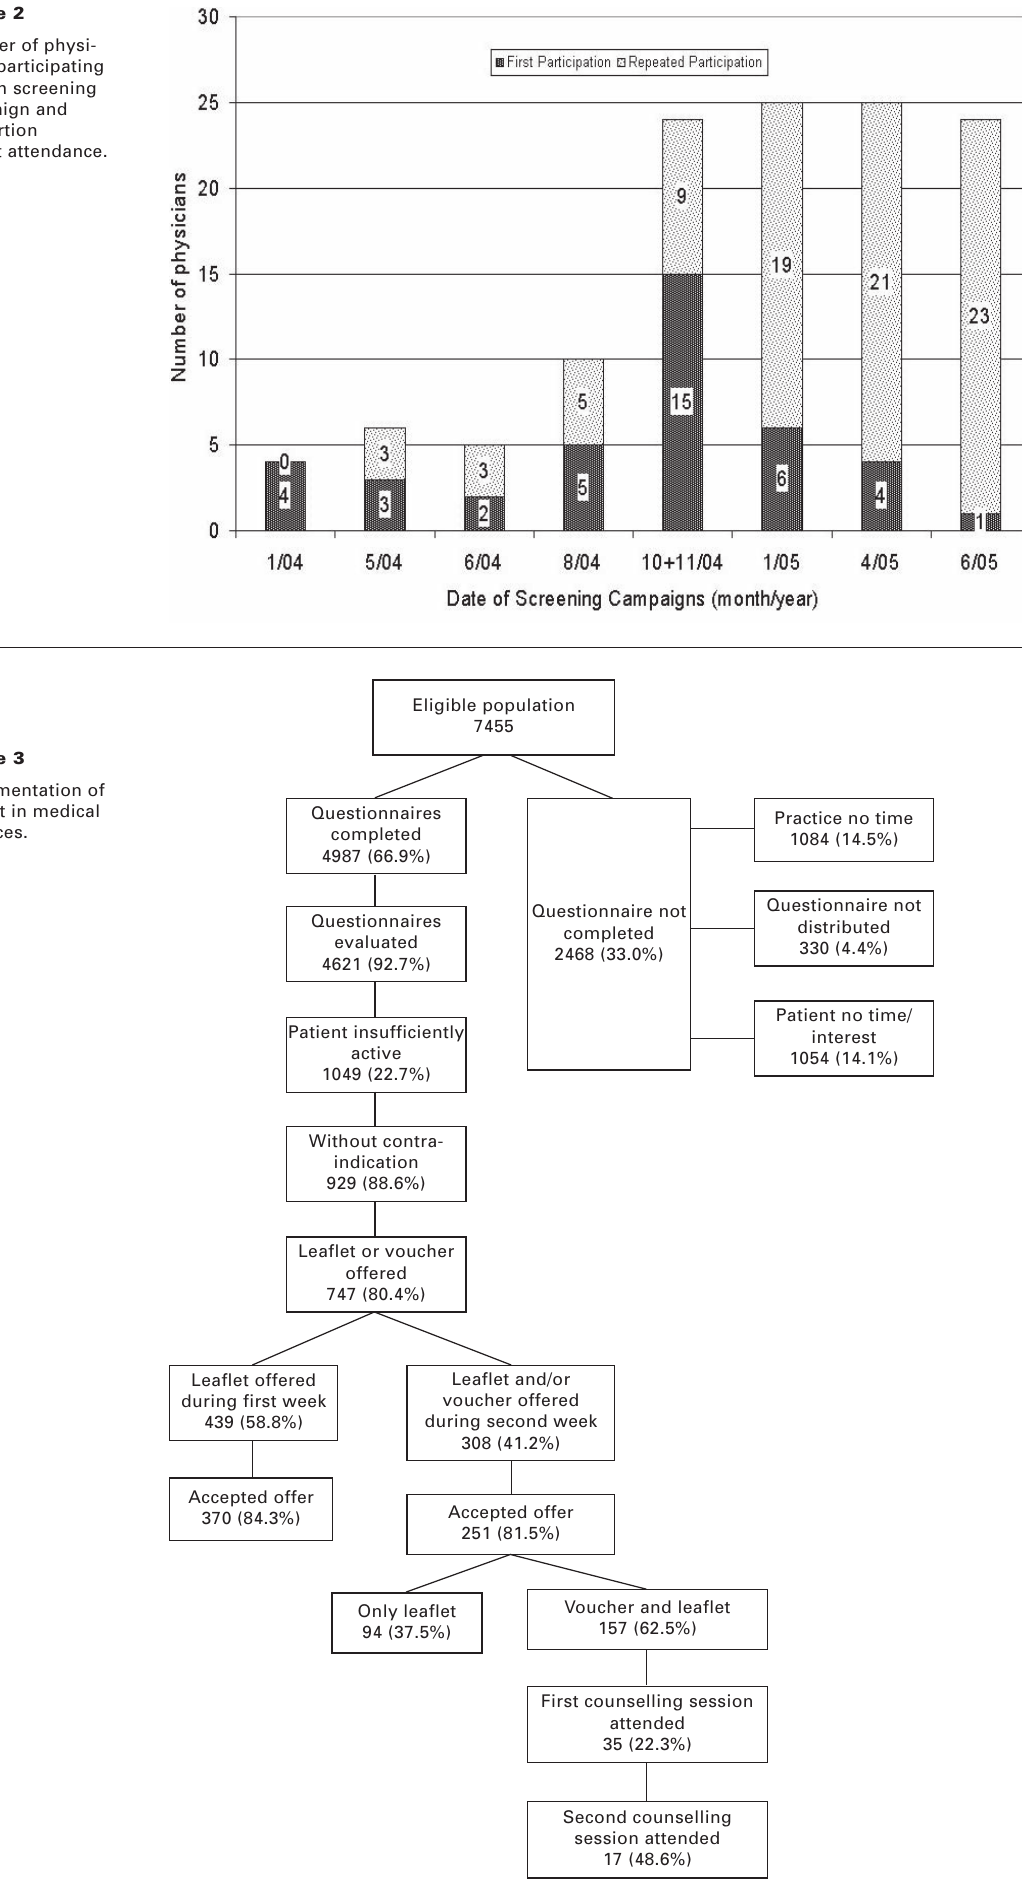
Figure 2 Number of physi- cians participating in each screening campaign and proportion of first attendance.